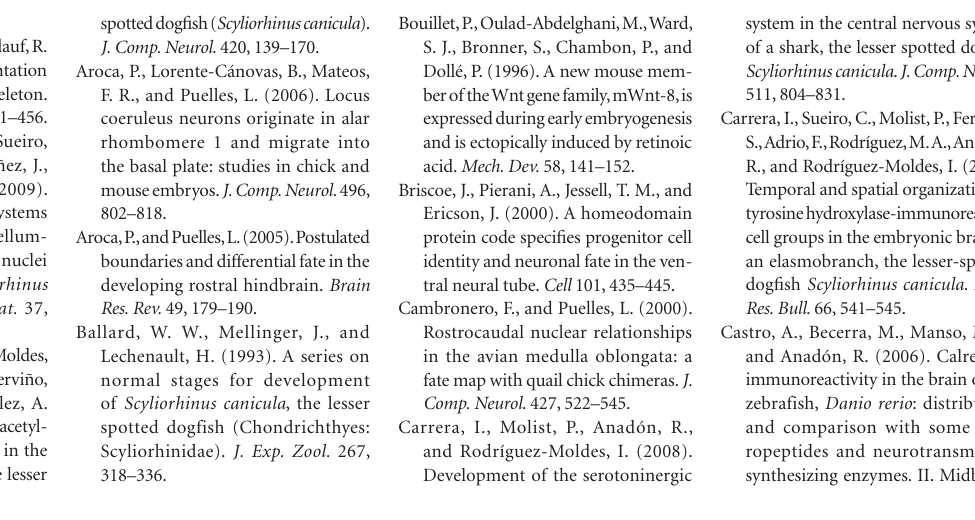
Figure 10 | Sagittal sections showing the distribution of ChAT-ir cell groups in the rhombencephalon at the stage 29. (A–D) Panoramic view (A) and details (B–D) of ChAT-ir cells of the oculomotor and trochlear nucleus (B) , trigeminal motor